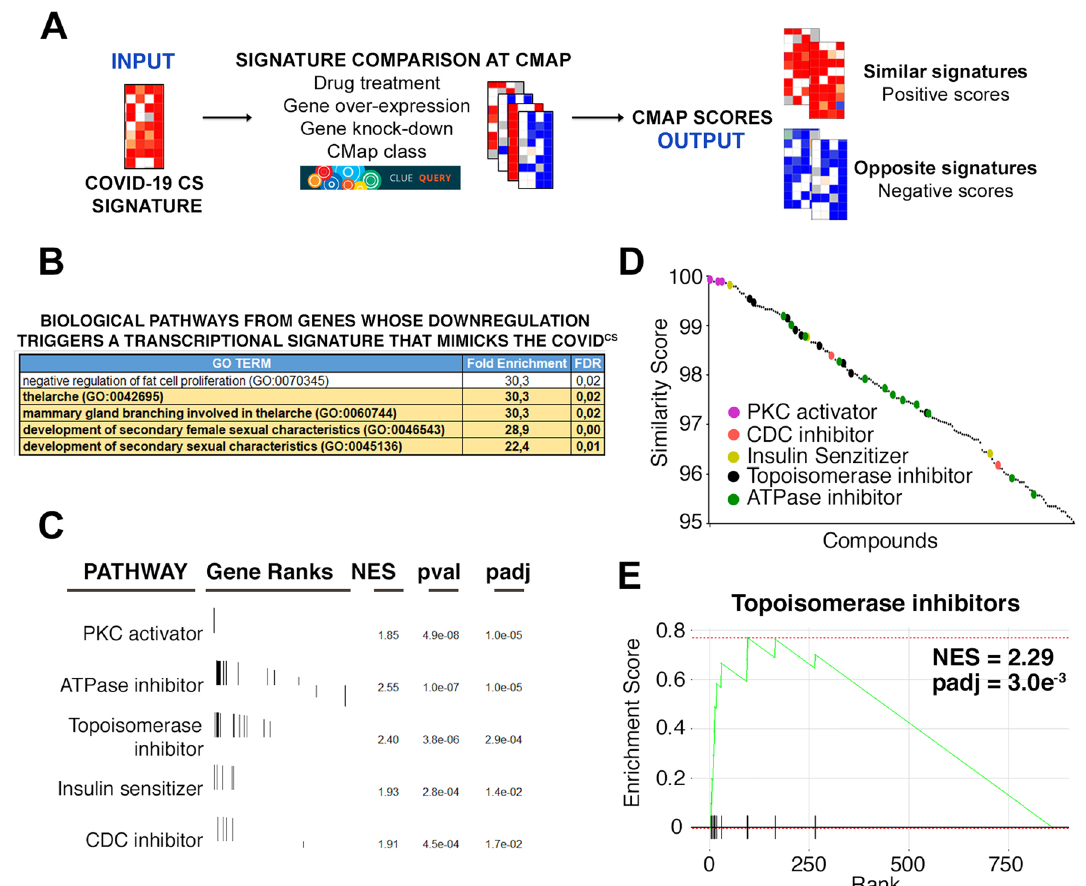
( A ) Scheme of the analysis pipeline. Transcriptional signatures defined from COVID-19 CS data were queried into the clue.io tool from CMap (http:// clue. io), to compare them to the signatures available at CMap linked to different perturbations (drug treatment, gene over-expression, gene knock-down and CMap class). The output of these analyses are similarity scores these being positive for signatures mimicking the COVID-19 CS signature, and negative for those opposing it. ( B ) Gene Ontology analysis of the biological pathways that are significantly enriched among genes for which their downregulation triggers transcriptional signatures that correlate to the COVID CS (Similarity score > 95). The panel represents those with a False Discovery Rate (FDR) < 0.05 and a fold enrichment > 22.4. Pathways related to female hormone signaling are highlighted in yellow. ( C ) Drug GSEA analysis of compound classes triggering a transcriptional signature that positively correlates to the COVID CS . Compounds were classified by their mechanism of action. ( D ) Similarity scores of specific compounds with a COVID CS similarity score bigger than 95. Compounds belonging to the classes defined in ( C ) are highlighted in different colors: PKC activators (purple), CDC inhibitors (pink), Insulin sensitizers (yellow), Topoisomerase inhibitors (black) and ATPase inhibitors (green). ( E ) Enrichment plot of Topoisomerase inhibitors resulting from the Drug GSEA analysis on medically approved compounds mimicking the COVID CS